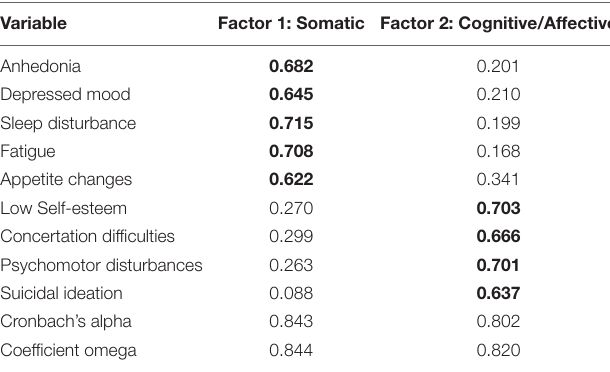
TABLE 3 | Exploratory factor analysis for Patient Health Questionnaire (PHQ-9) instrument. Variable Factor 1: Somatic Factor 2: